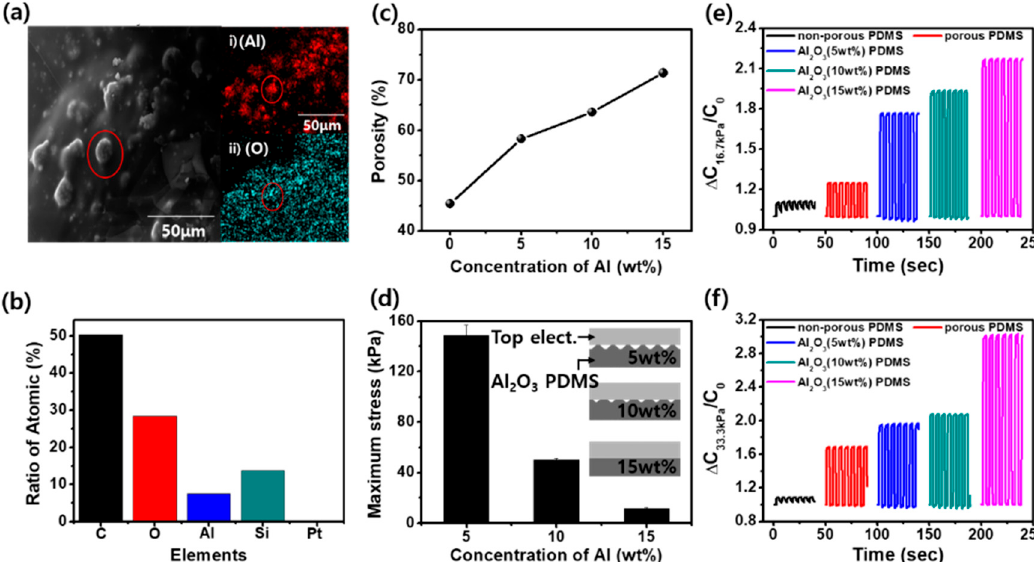
Figure 2. Characterizations of mesoporous Al 2 O 3 -PDMS. ( a ) SEM and EDS images of the elemental maps of (i) Al (red) and (ii) O (cyan); ( b ) ratio of atomic % of mesoporous Al 2 O 3 -PDMS; ( c ) porosity; ( d ) compressed strength at a deformation of 8 mm; the inset is the schematic of the intensity of deformation by compressed strength; and ( e , f ) relative capacitance change ( ∆ C 16.7kPa , ∆ C 33.3kPa ) to the initial capacitance under no pressure (C 0 ) of non-porous PDMS and mesoporous Al 2 O 3 -PDMS (0, 5, 10, 15 wt%).